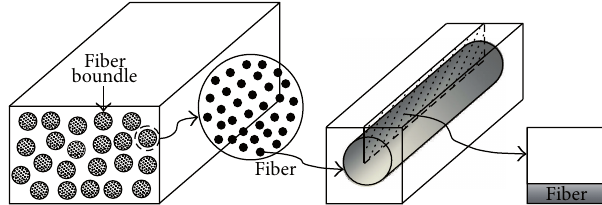
F 3: Schematic illustrations of unidirectional �ber-reinforced